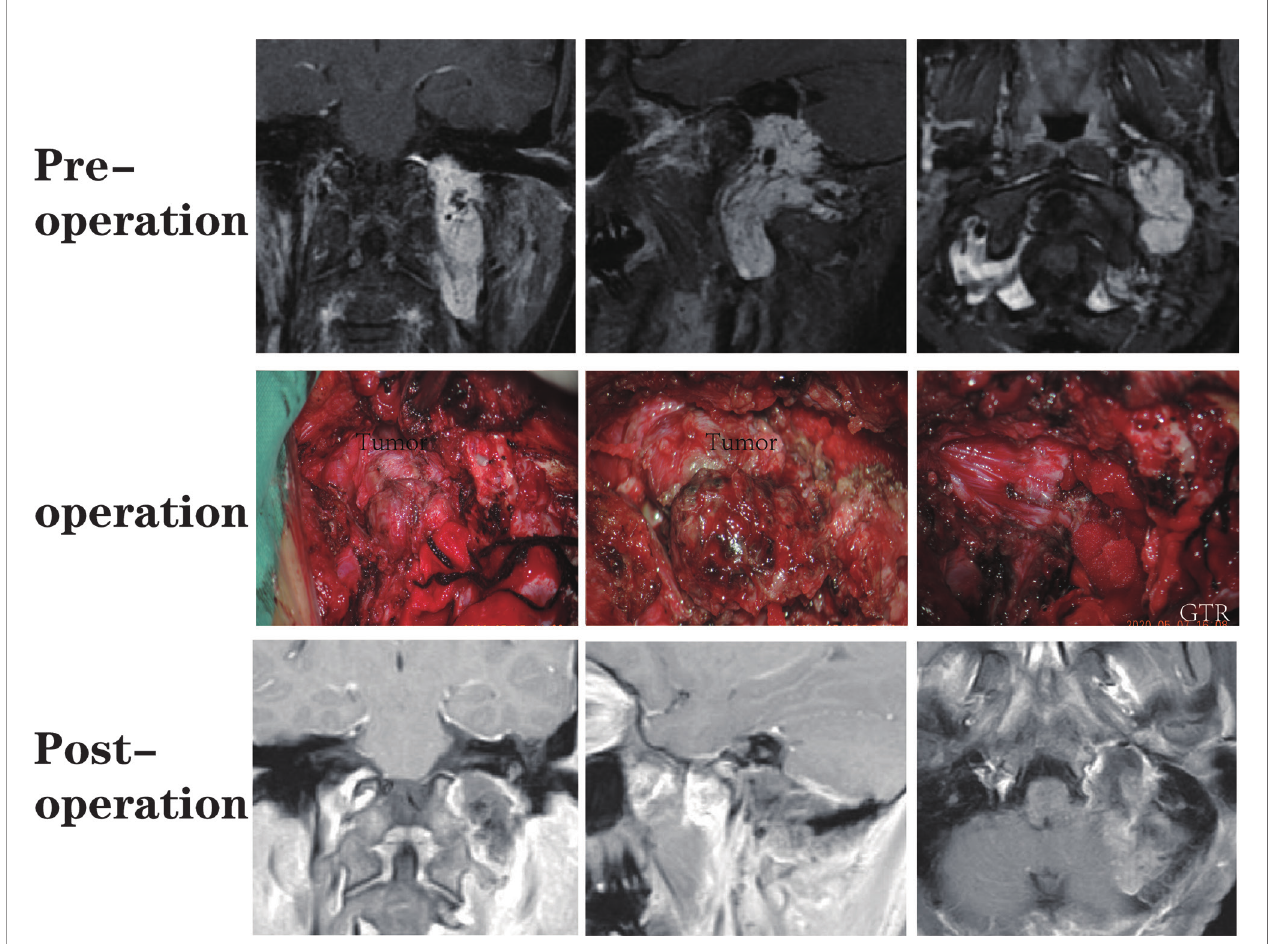
FIGURE 7 | A patient with a jugular foramen paraganglioma who underwent suboccipital paracondylar-lateral cervical approach.